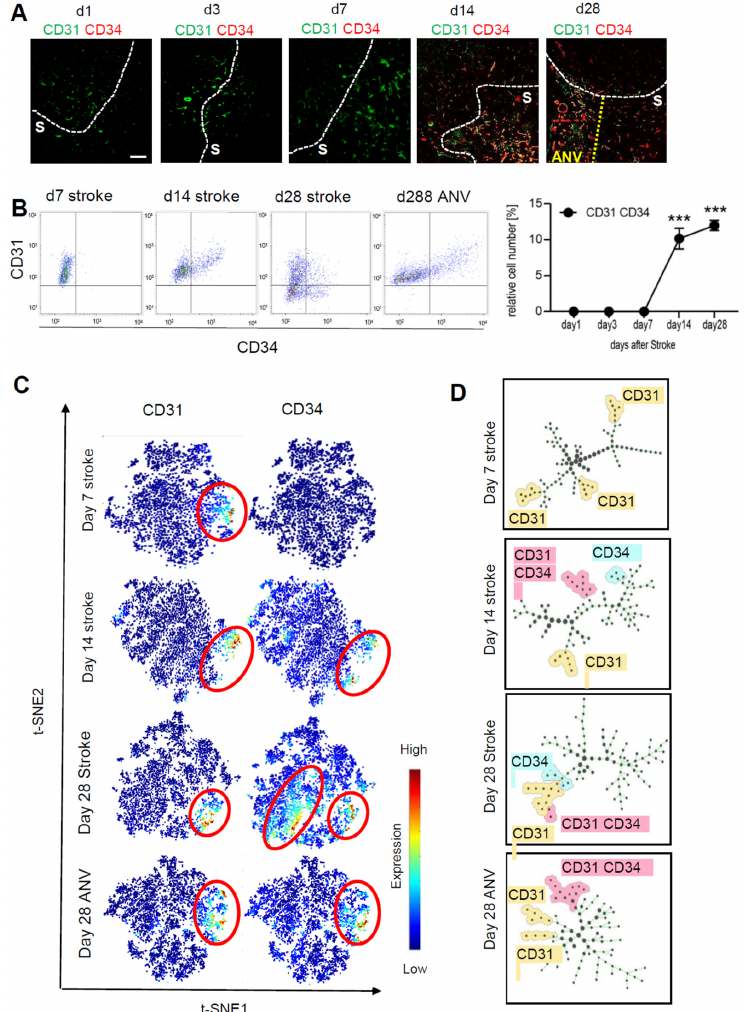
Figure 3. Analysis of neoangiogenesis over time of the stroke area. ( A ) Representative MELC images showing CD31 and CD34 staining in healthy tissue, stroke area (S) and the ischemic core area of neovascularization (IC-ANV) at the indicated times. The white bar represents 100 µm. ( B ) Quantitative assessment of CD31 + /CD34 + endothelial cells based on the MELC images using flow cytometry standard format in the ischemic core and IC-ANV. Data are shown as mean ± S.E.M (n = 4). One-way ANOVA/Bonferroni *** p < 0.001. ( C ) tSNE maps with highlighted CD31 and CD34 expression at the indicated times. ( D ) Identification of cell subpopulations and cell transitions using SPADE analysis at the indicated times in the ischemic core and IC-ANV.